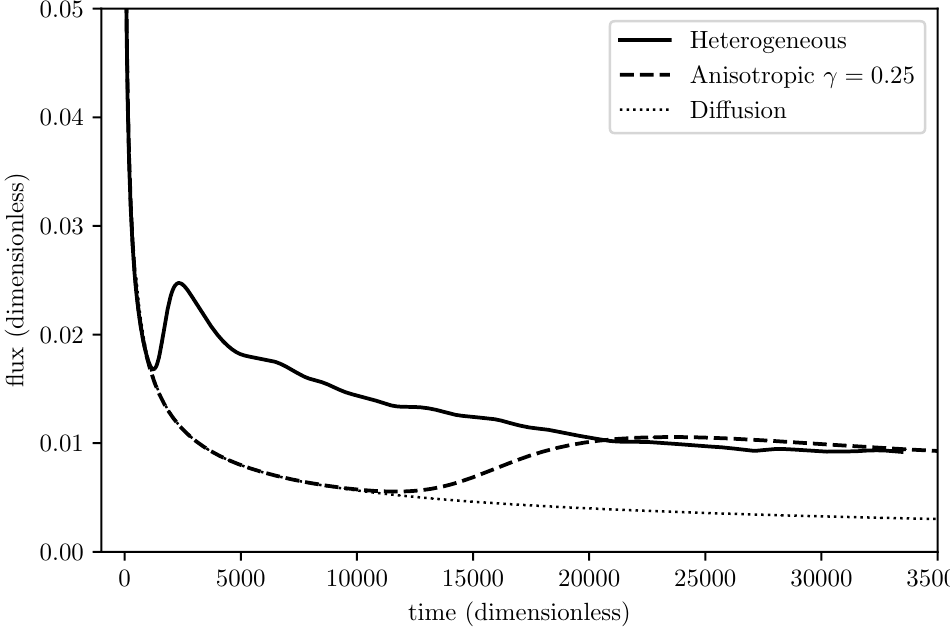
Figure 8. Dimensionless flux across the top boundary for the heterogeneous model with elliptical barriers (solid line) and the equivalent anisotropic model with γ = 0.25 (dashed